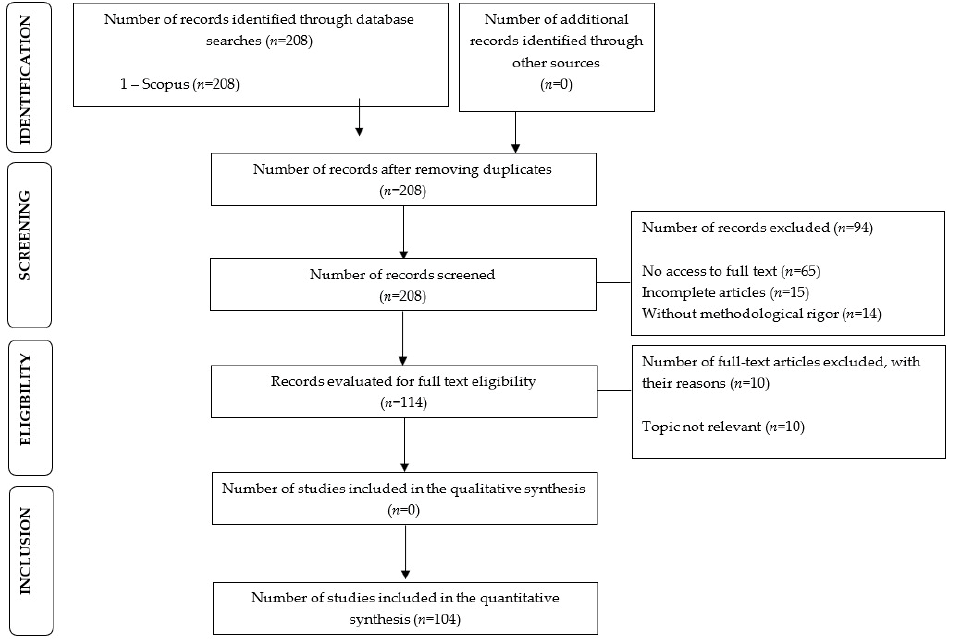
Figure 1. PRISMA flow diagram of identification, screening and eligibility assessment. Own elabo- ration.